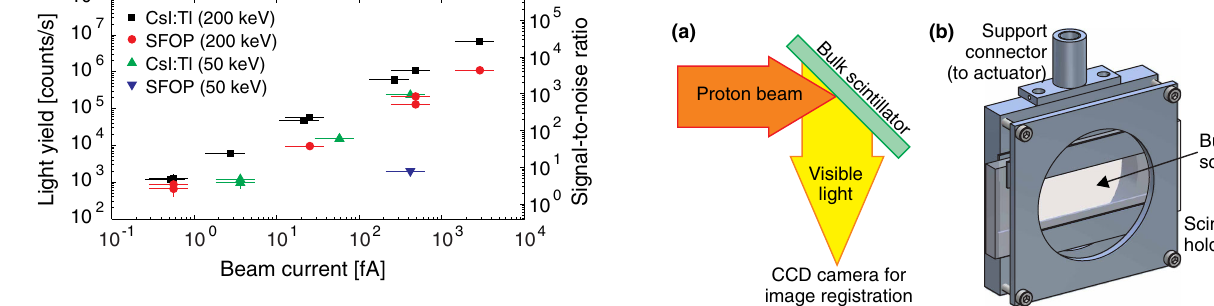
FIG. 2. Bulk-scintillator based profile monitor: (a) placement schematic, and (b) mechanical design for the USR.